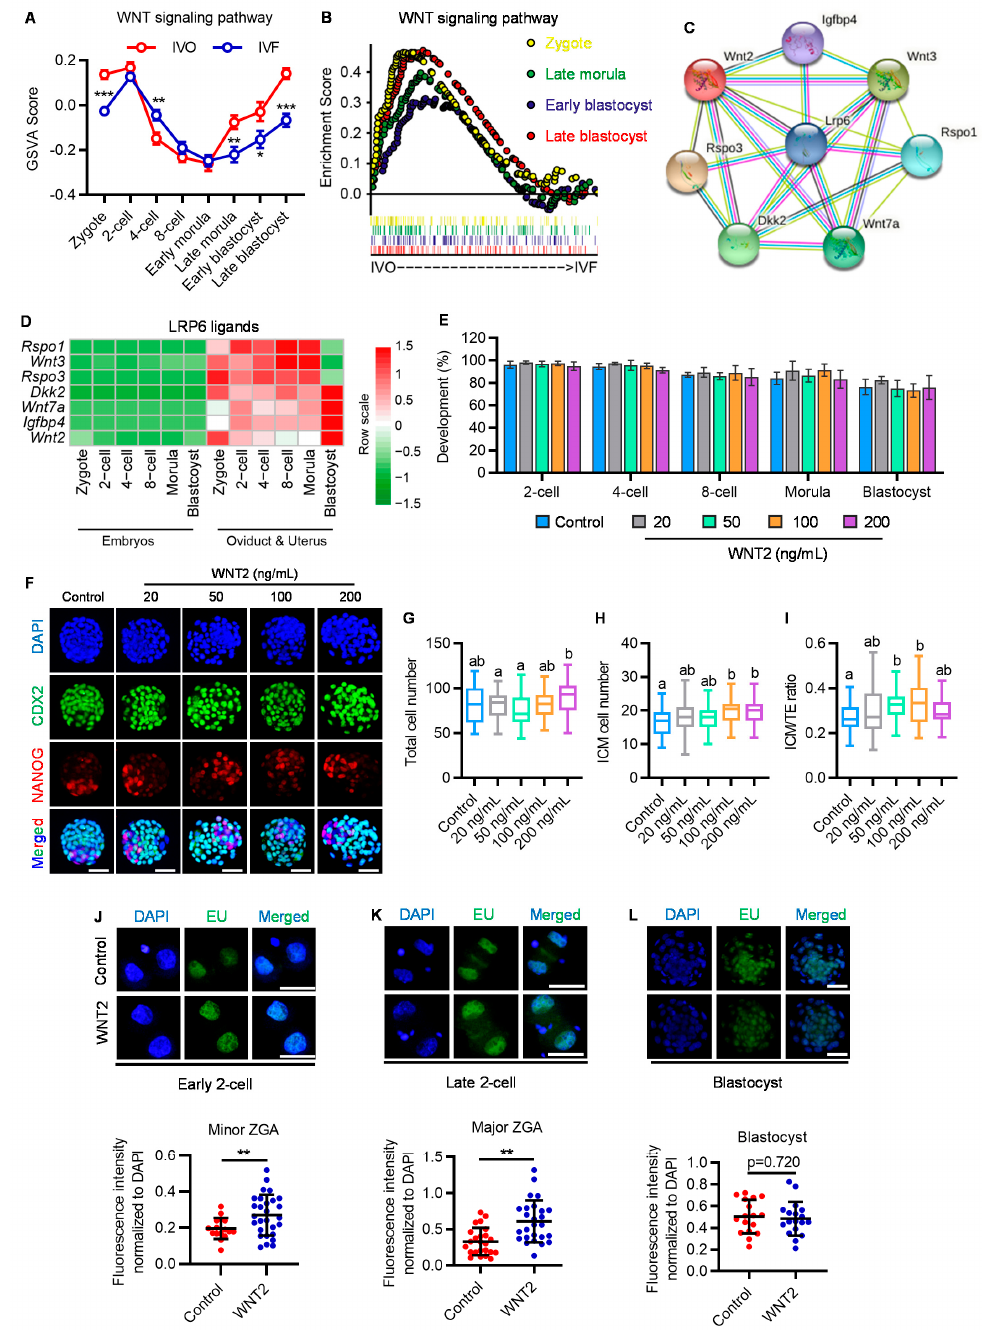
Figure 3. Exogenous WNT2 promotes embryo development via interacting with LRP6. ( A ) GSVA plot showing the dynamic activity of WNT signaling in IVO and IVF preimplantation